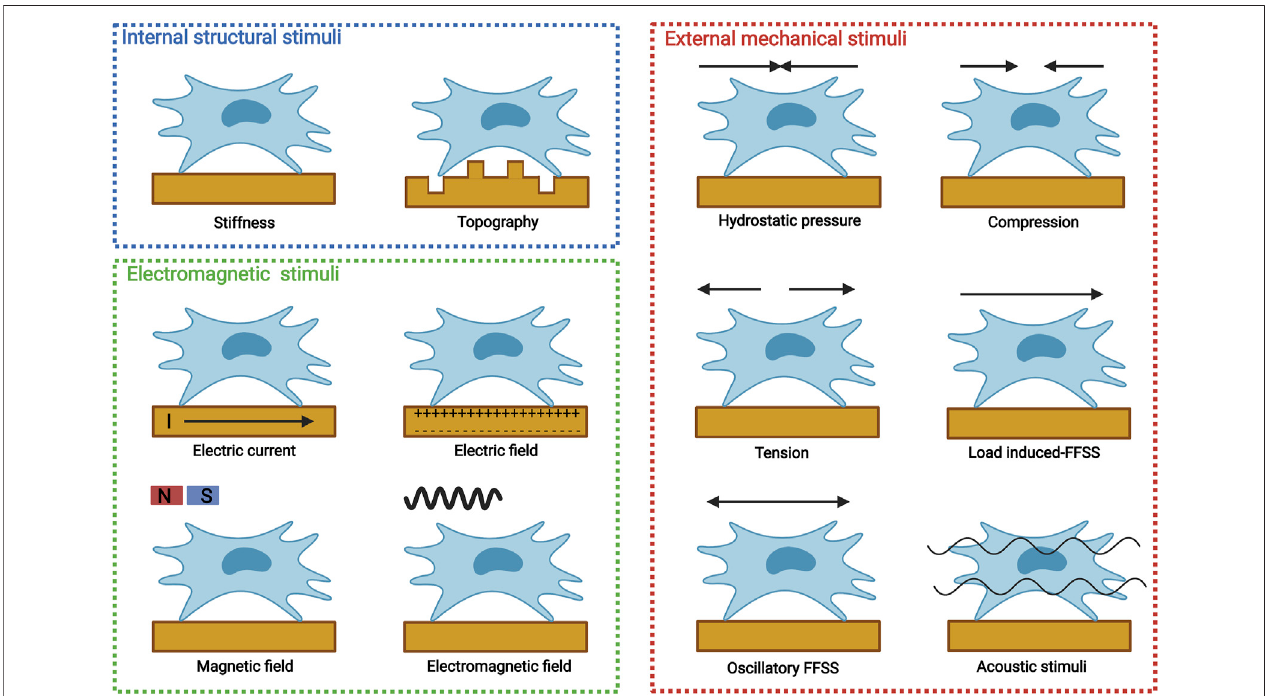
FIGURE 2 | Distinctive biophysical stimuli for bone tissue engineering, including internal structural stimuli (stiffness and topography), external mechanical stimuli [hydrostaticpressure,compression,tension,loadinduced- fl uid fl owshearstress(FFSS),oscillatoryFFSSwithoutload,andacousticstimuli],andelectromagneticstimuli (electric current, electric fi eld, magnetic fi eld, and electromagnetic fi eld). Created with BioRender.com.